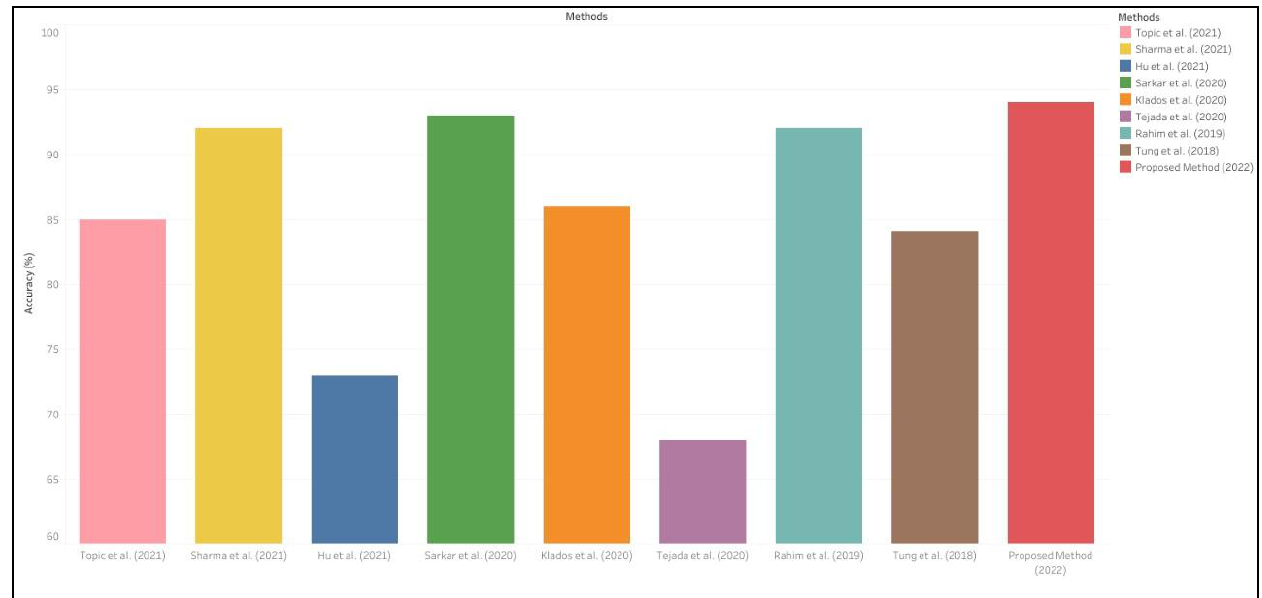
Figure 7. Comparison of proposed method with previous state-of-the-art method [1,8,10,16,17,19,20,21].